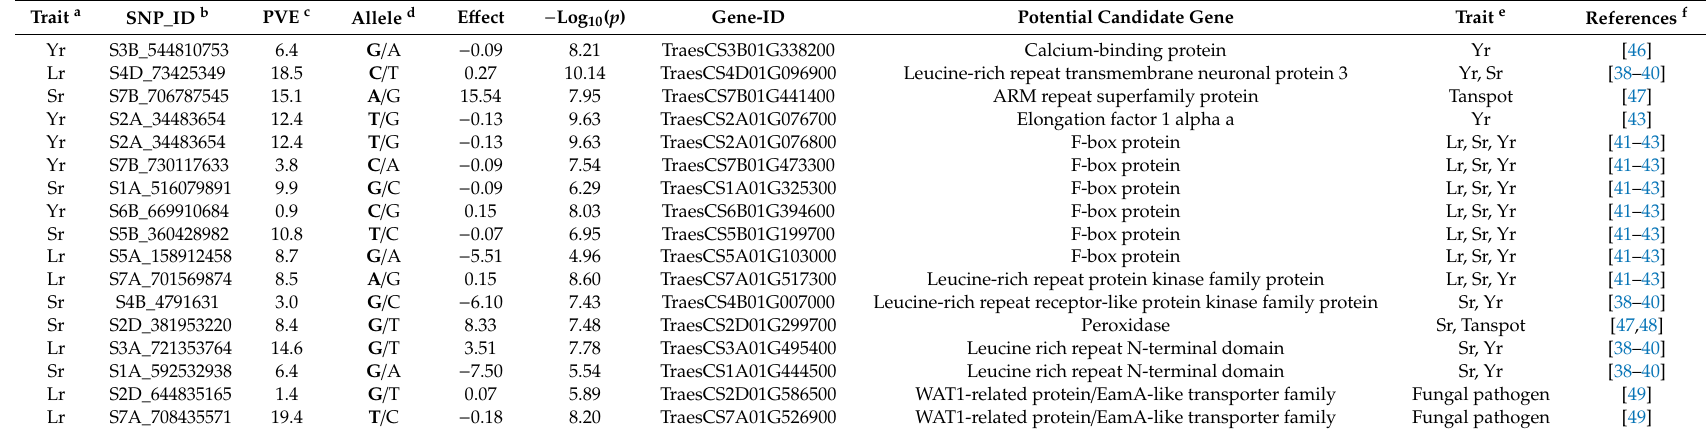
Table 1. List of potential candidate genes found in regions identified by marker-trait associations for disease resistance, favorable allele (bold), and SNP e ff ects in 125